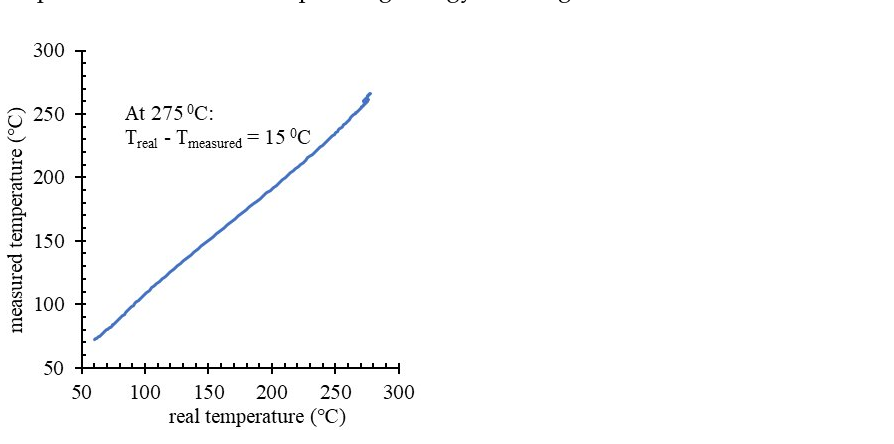
Figure 7. The accuracy of T3–T5 thermocouple response to temperature dynamics inside the storage tank.